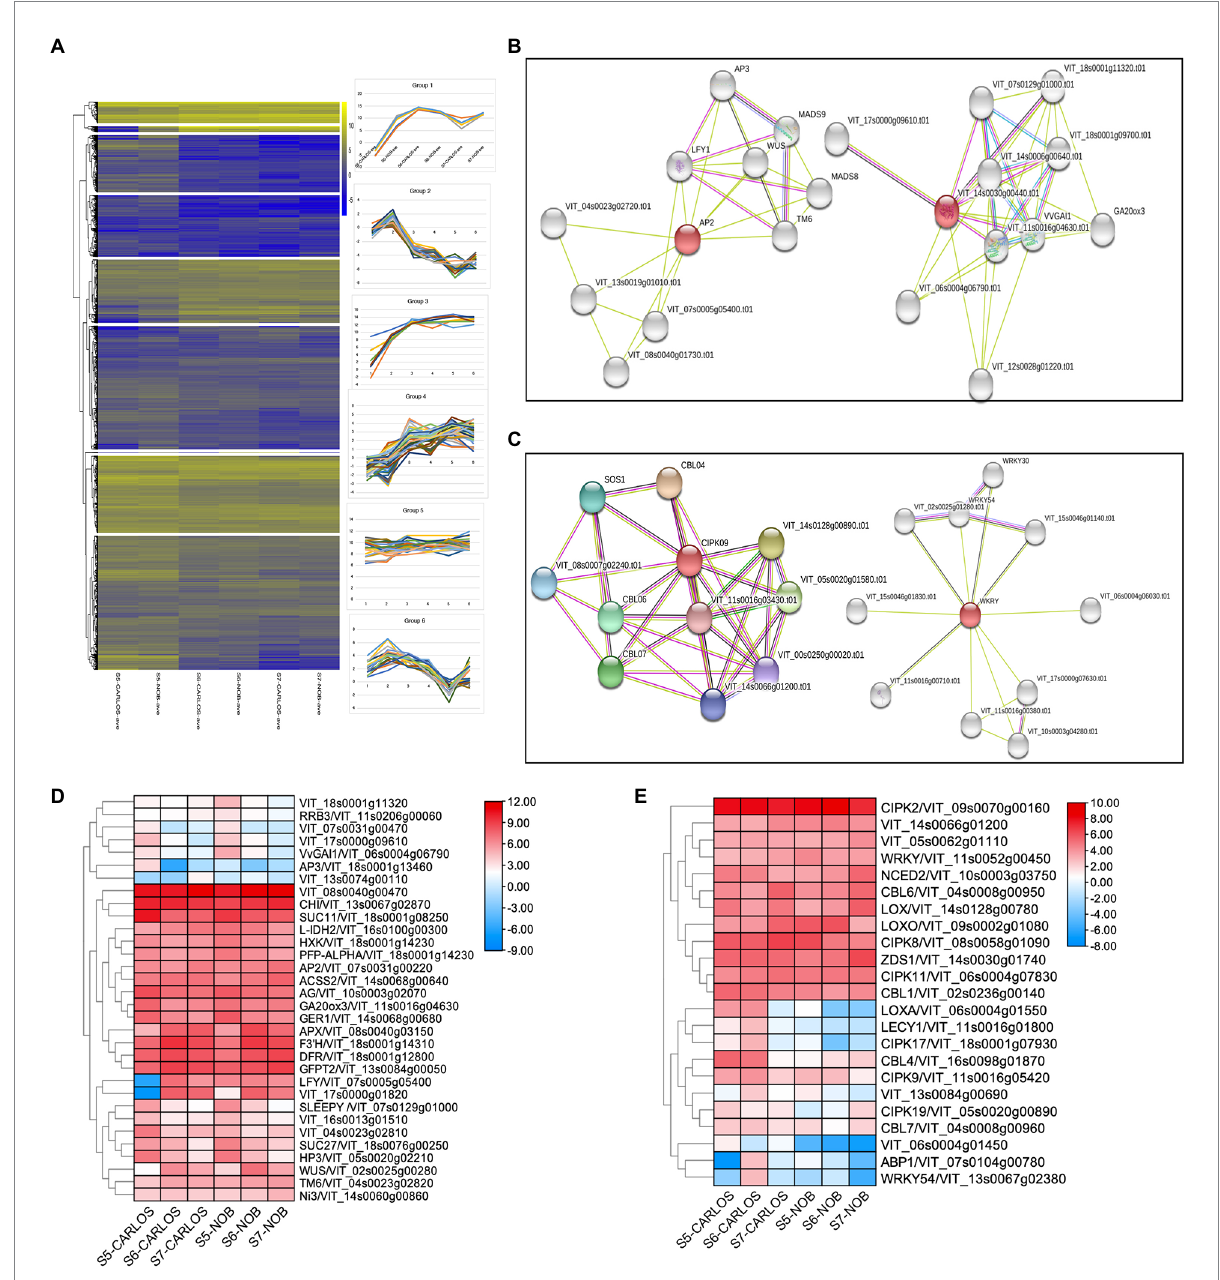
FIGURE 5 Gene regulatory networks in berry ripening. (A) Cluster analysis revealed seven expression patterns in this experiment. (B) Clusters from functional network analysis of the developmental hub genes of AP2 on the left and GA20ox3 on the right. (C) Functional network analysis of the environmental hub genes CIPK09 on the left and WRKY on the right. (D) Heatmap showing the expression patterns of developmental regulators. (E) Heatmap showing the expression patterns of environmental